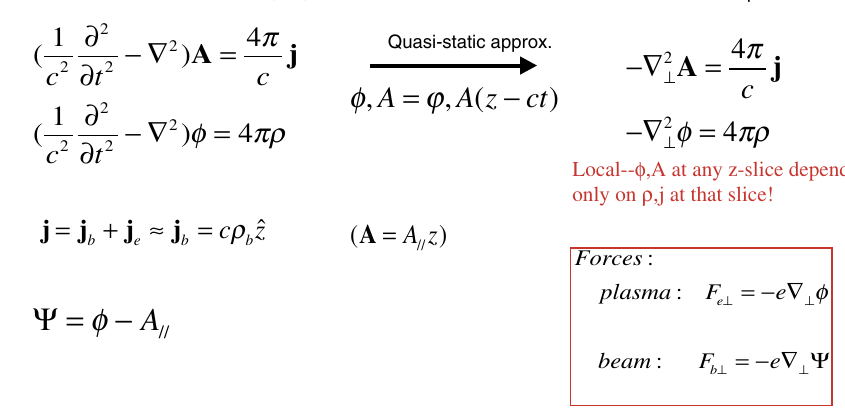
FIG. 1. (Color) Quasistatic or frozen field approximation used in QUICKPIC .